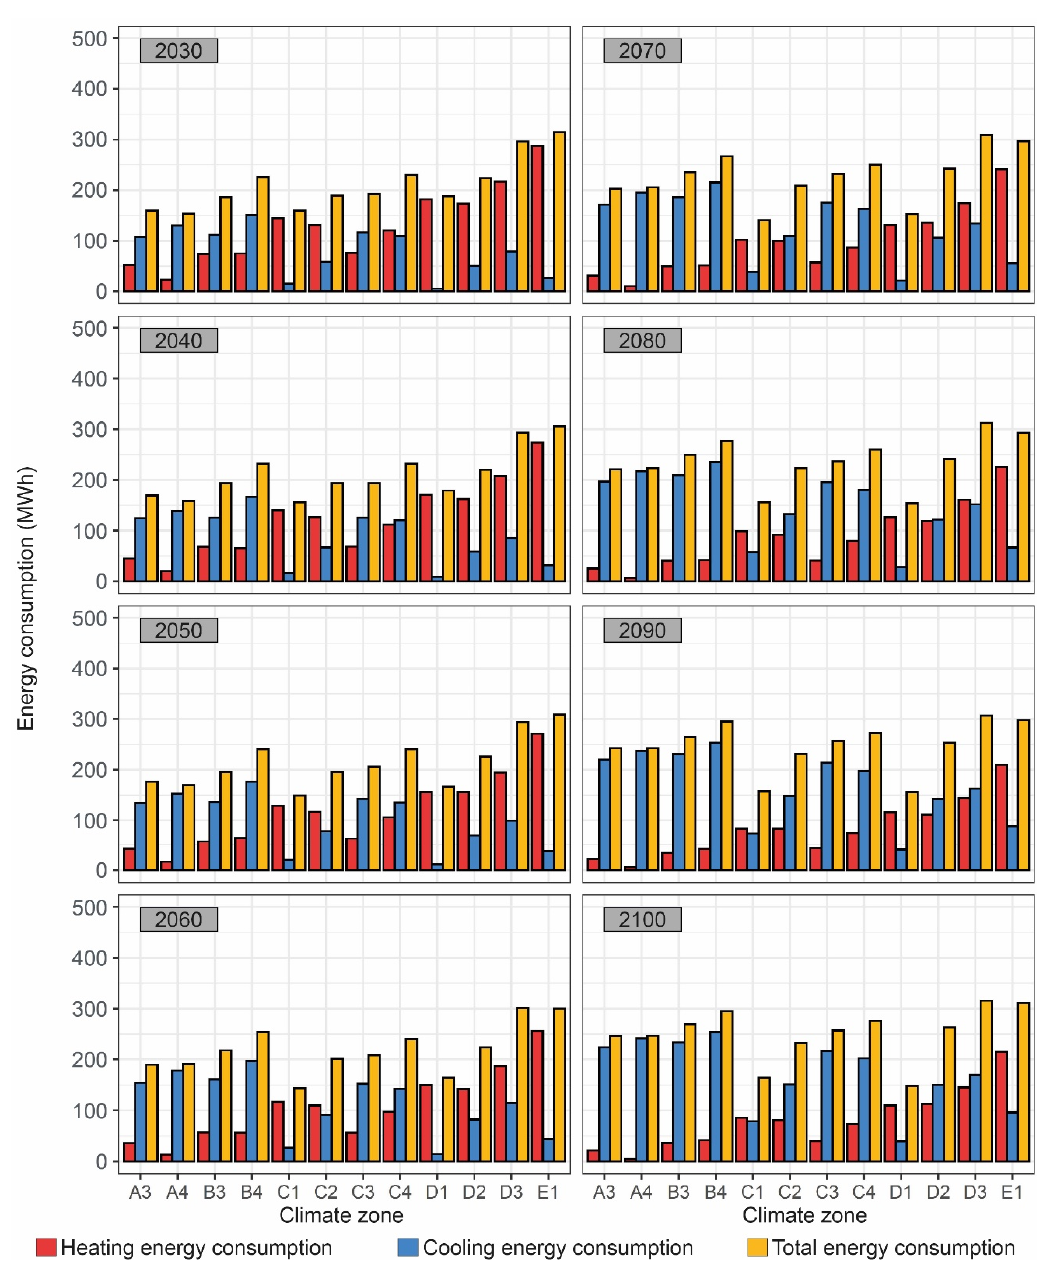
Figure 9. Energy consumption of the building without improving its envelope throughout the 21st century and considering an operational pattern based on users working outside the home.